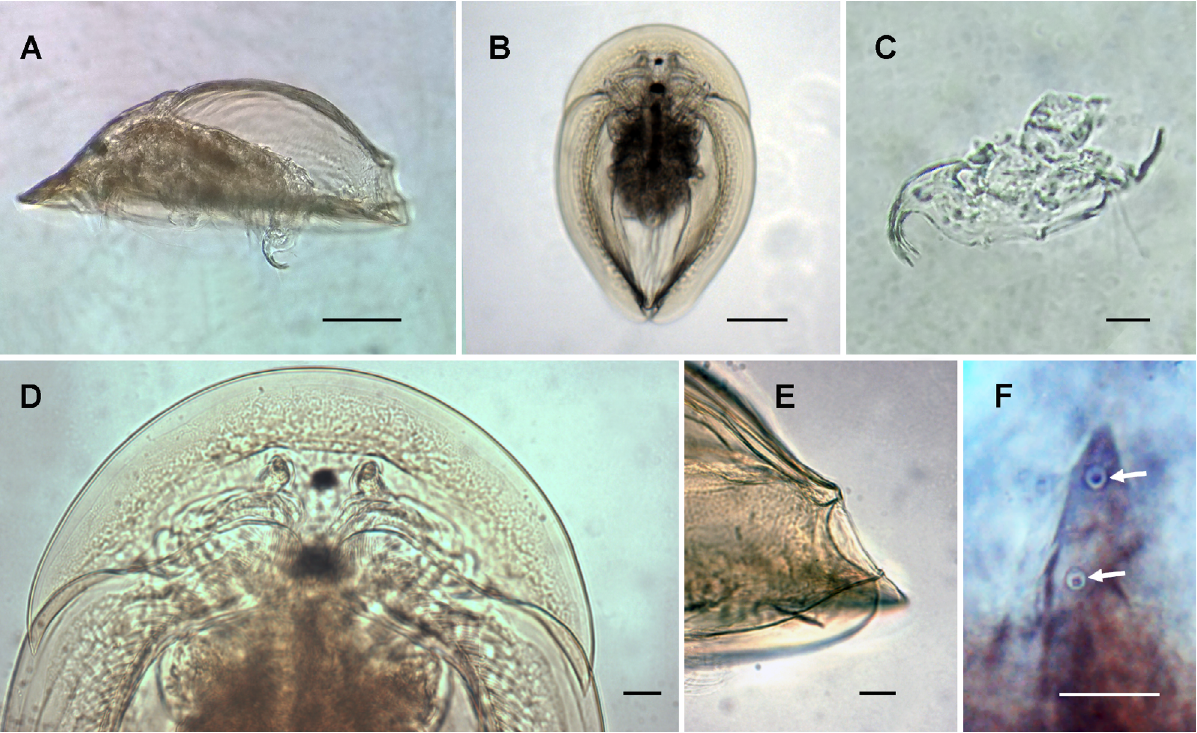
Figure 2. Kisakiellus aweti from the Araguari River, state of Amapá, Brazil. A, habitus; B, ventral view; C, postabdomen; D, head in ventral view, evidencing the fornices projected backwards; E, posterior margin of the carapace; F, head pores (arrows). Scale bars: A,B = 100 μm; C–F = 20